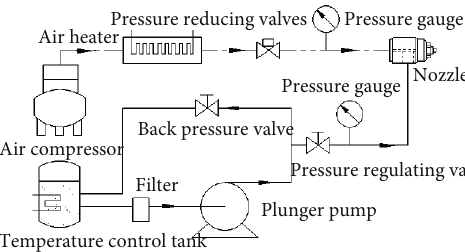
Figure 4: Spray system schematic diagram.